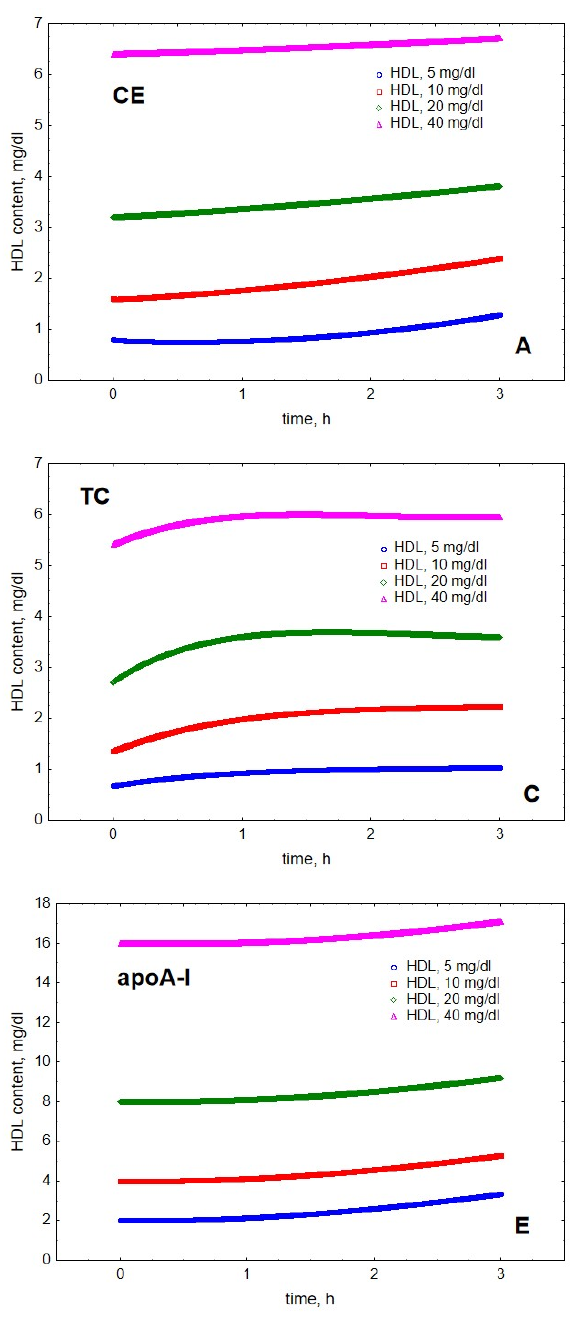
Figure 1. Kinetics of HDL content of CE ( A ), FC ( B ), TC ( C ), PL ( D ) and apoA-I ( E ) during VLDL lipolysis by LPL in the presence of HDL. Mathematical modelling was performed under conditions of in vitro TGRL lipolysis described elsewhere [25]. Initial concentrations: HDL, 5 (blue circles), 10 (red squares), 20 (green diamonds) and 40 (purple triangles) mg total mass/dL; VLDL-TG, 30 mg/dL; LPL, 190